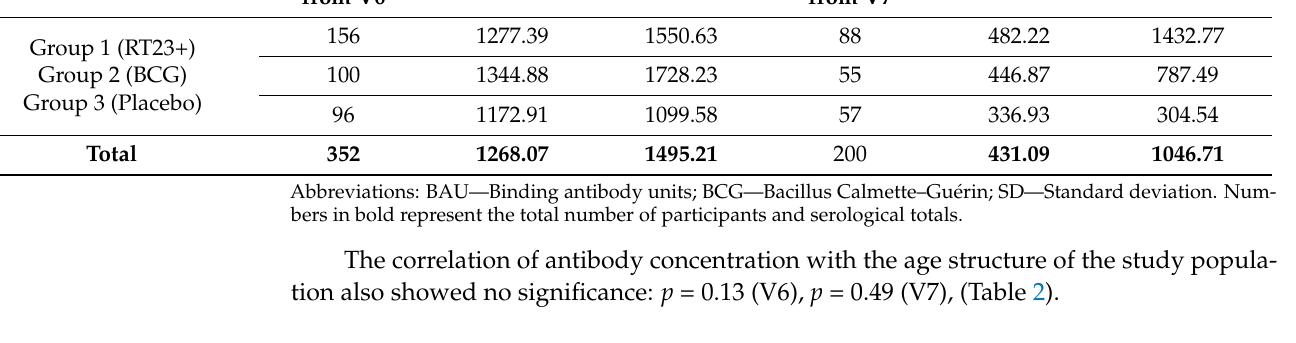
Table 2. Antibody concentration according to the age of the study participants.